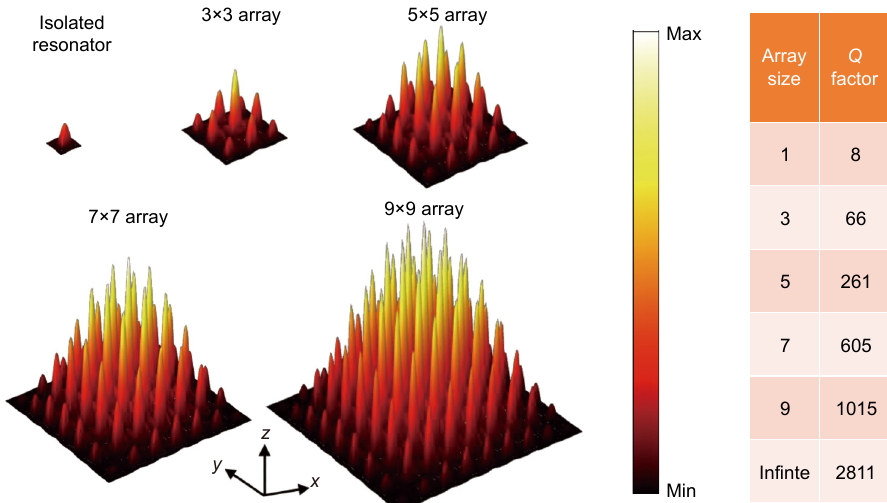
Fig. 4 | Magnitude plots of the on-resonance magnetic field for the isolated resonator and 3×3, 5×5, 7×7, and 9×9 arrays. The magnetic field distributions are obtained at the vertical mid-plane of the blocks and the magnitude is indicated by the height. The structural parameters are l =0.4 μm, a =0.15 μm, b =0.1 μm, s =1.2. The table on the right shows the corresponding Q